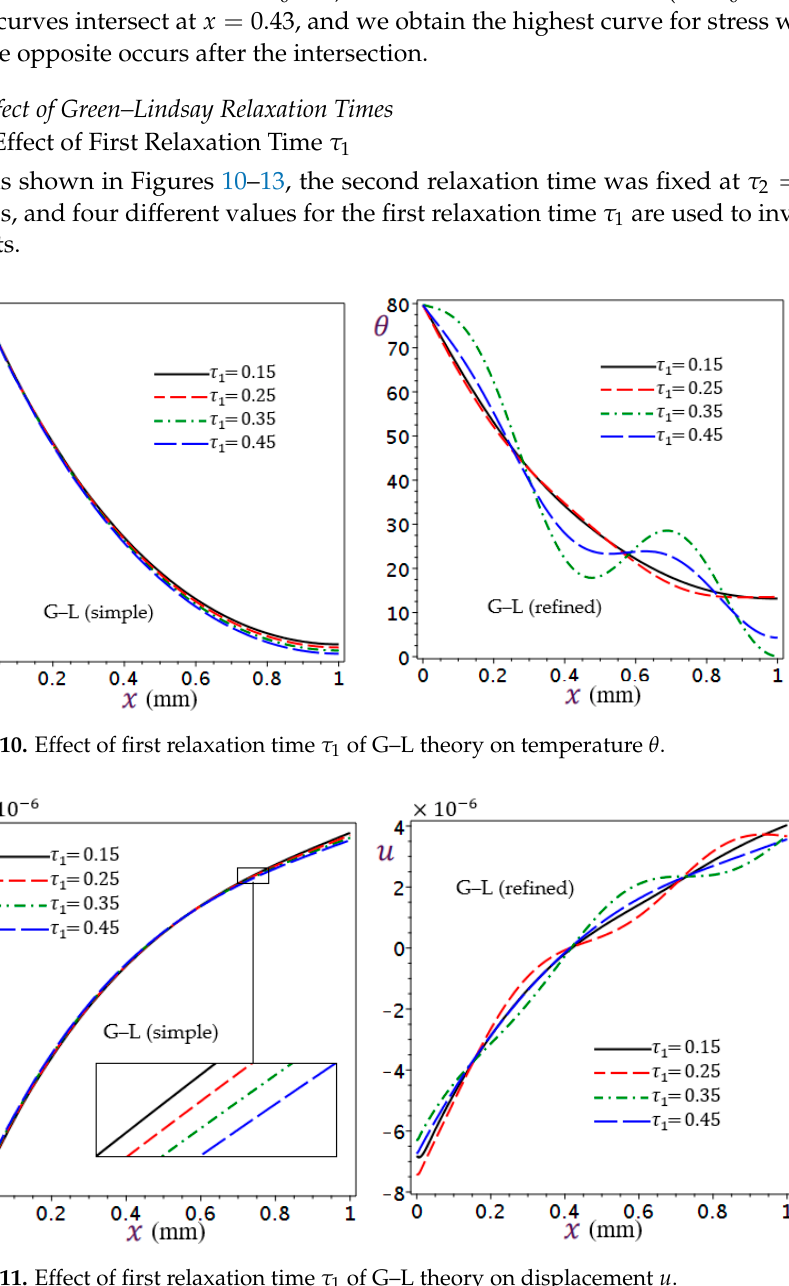
Figure 11. Effect of first relaxation time τ 1 of G–L theory on displacement u